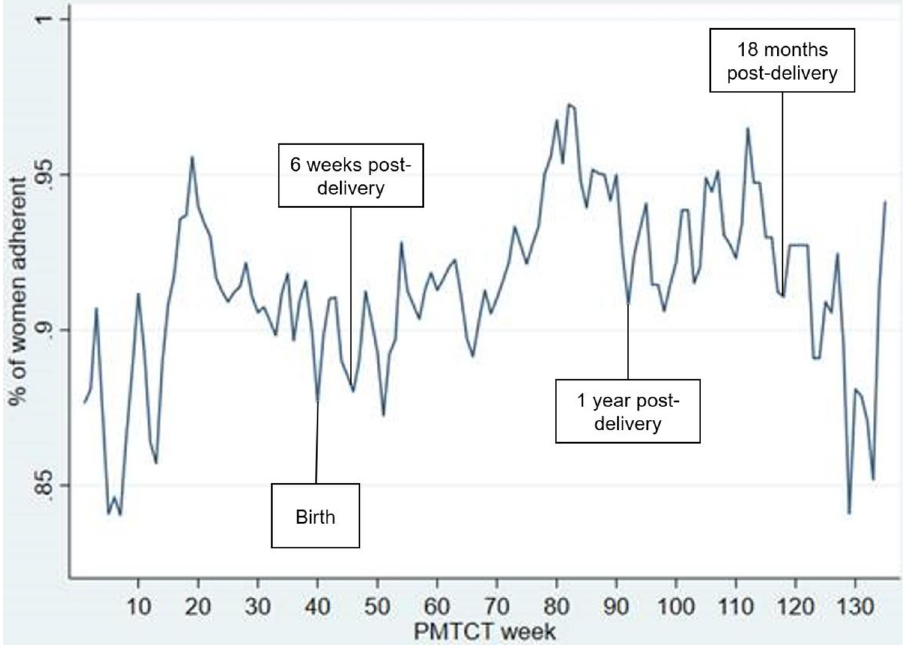
Fig 4. Proportion of women who were adherent over the PMTCT